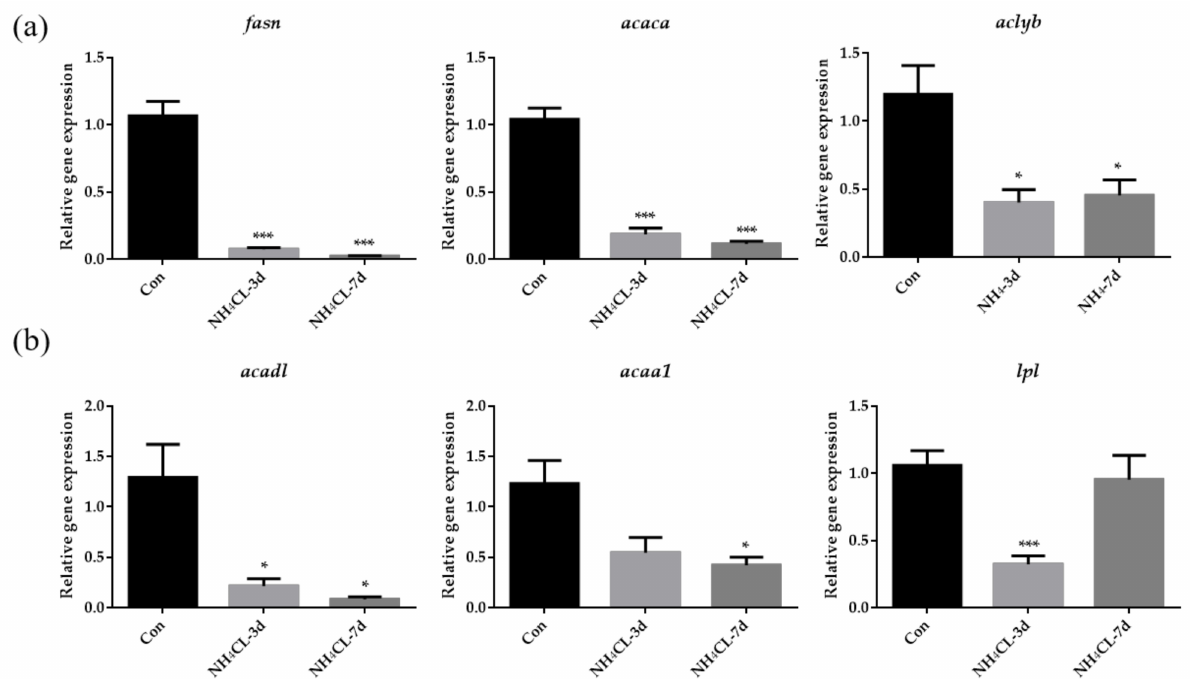
Figure 4. The lipid metabolism in largemouth bass liver after ammonia exposure for 3 days and 7 days was affected. The relative expression of genes involved in lipid synthesis ( fasn , acaca , aclyb ) ( a ) and lipolysis ( acadl , acaa1 , lpl ) ( b ) in largemouth bass liver after ammonia exposure. All data were analyzed with Student’s t -test and data were mean ± SEM ( n = 6). * p < 0.05; *** p < 0.001.